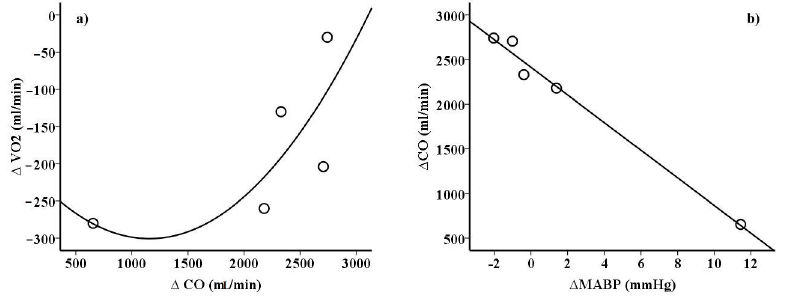
Figure 2. Relationship between changes from normoxia to hypoxia of ( a ) peak oxygen consumption (VO 2 ) and cardiac output (CO) (r 2 = 0.91, Spearman) and ( b ) CO and mean arterial blood pressure (MABP) (r 2 = 1.0,